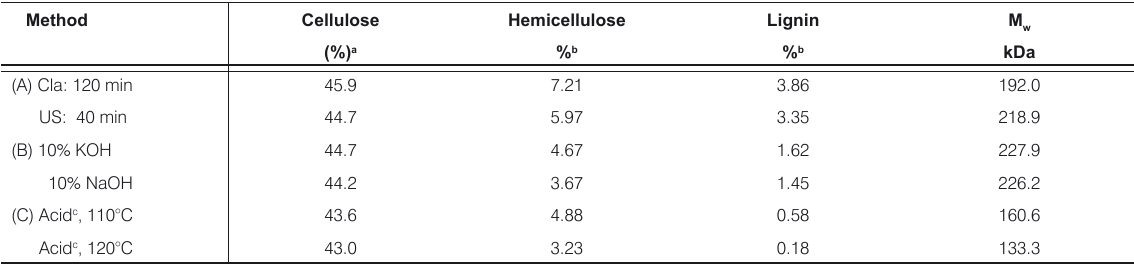
Table 6. Effect of ultrasonication on the yield and purity of cellulose isolated from sugarcane bagasse by classical (Cla) and ultrasound (US) treatments.